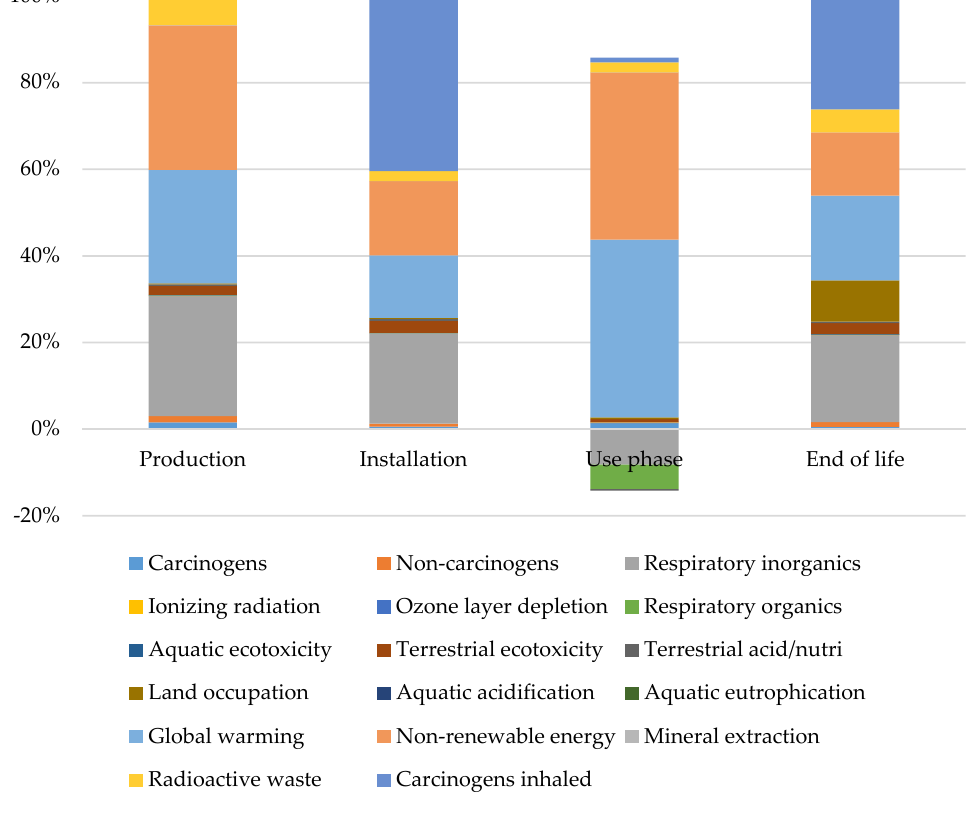
Figure 2. Evaluation by single score of 1 m 2 of nanoTiO 2 self-cleaning coated float glass.